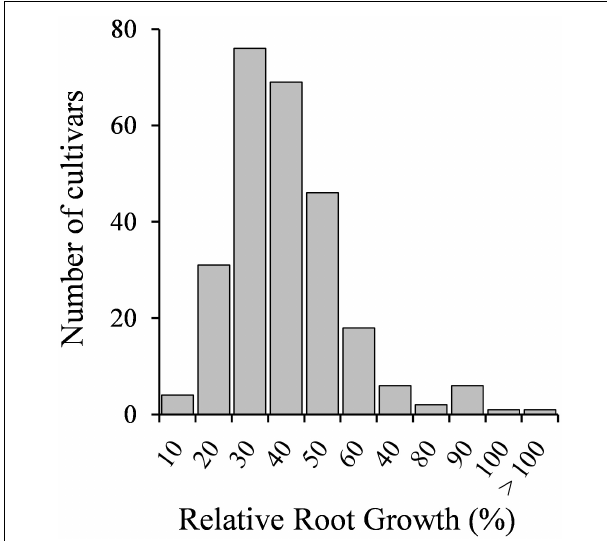
FIGURE 1 | Seedling relative root growth (RRG) distribution of 258 M. truncatula accessions grown in the absence or presence of Cd stress (10 µ M CdCl 2 , 48 h).